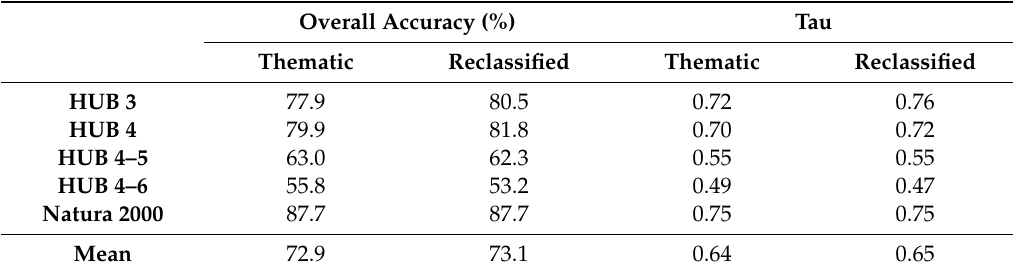
Table 5. Observed vs. predicted accuracy from 154 testing sites for thematic maps (thematic distribution BRT models) and reclassified thematic maps (from continuous BRT